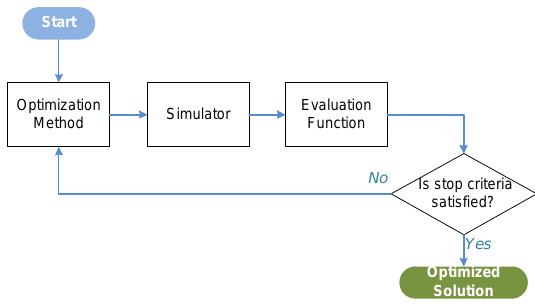
Figure 4. Applied optimization